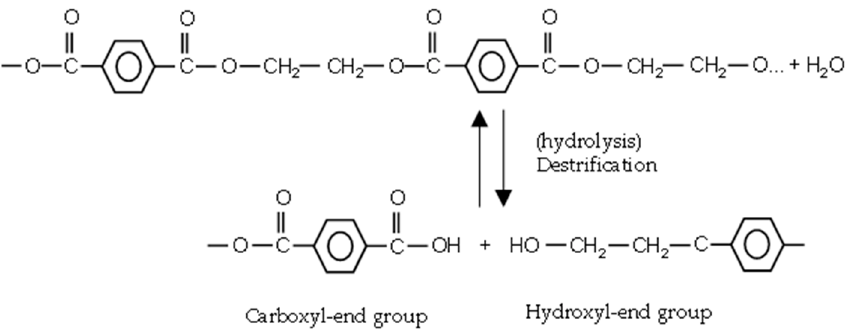
Figure 6. Hydrolysis reaction of PET.